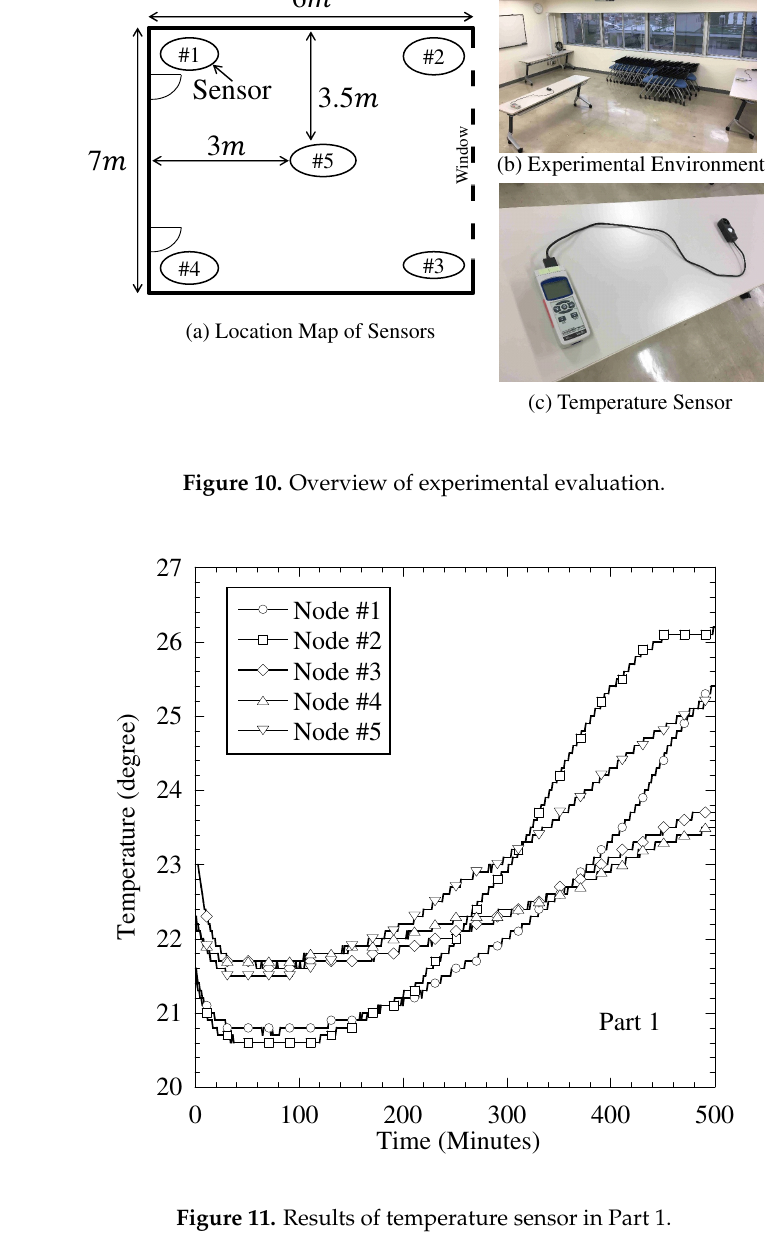
Figure 11. Results of temperature sensor in Part